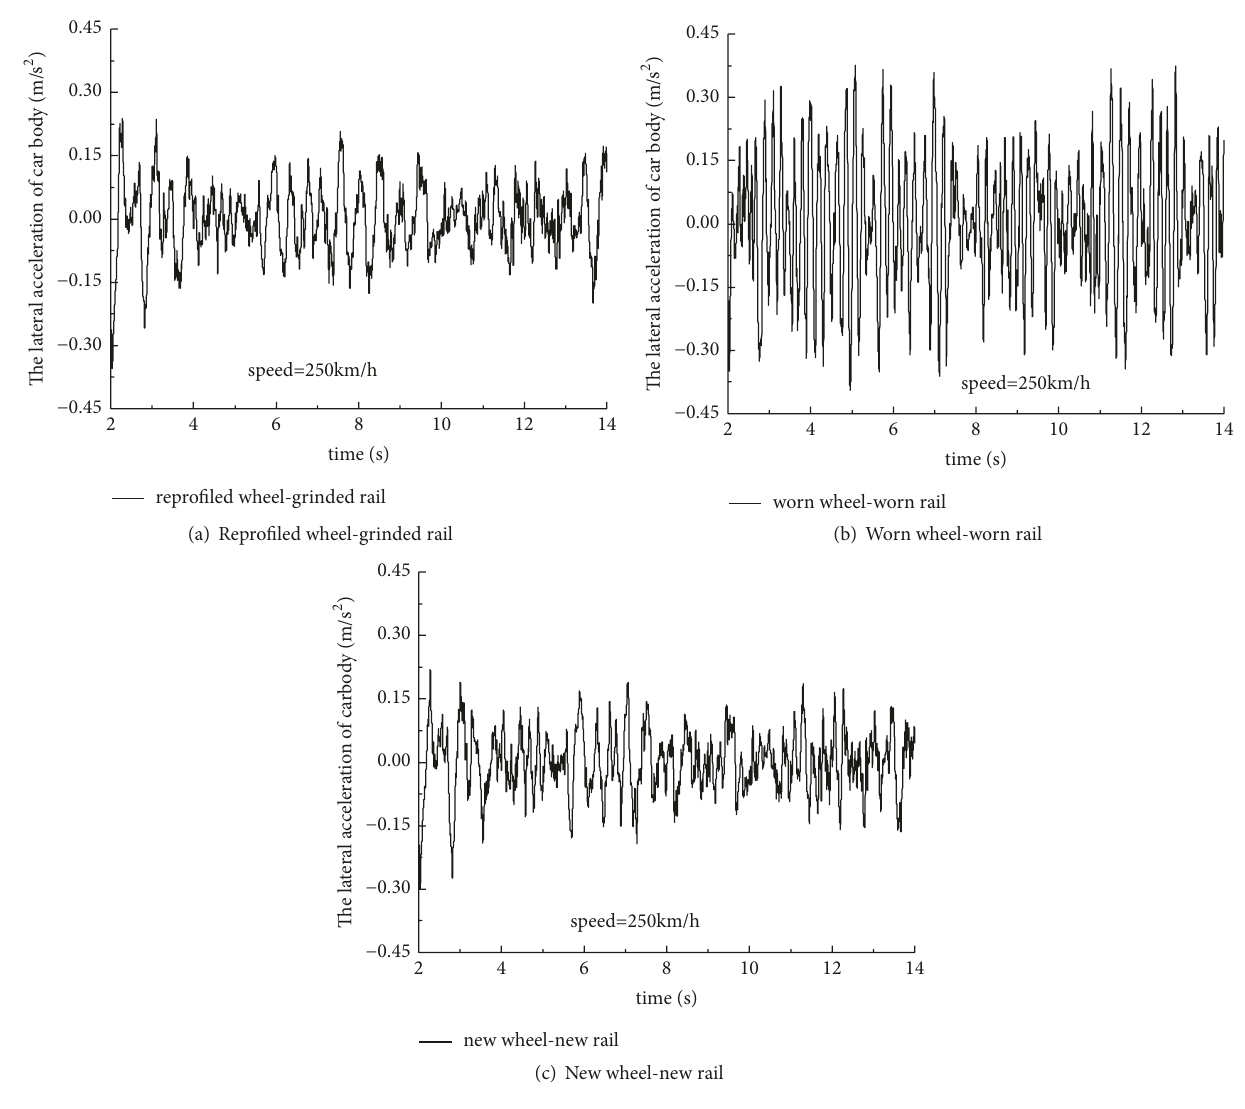
Figure 16: The lateral acceleration of car